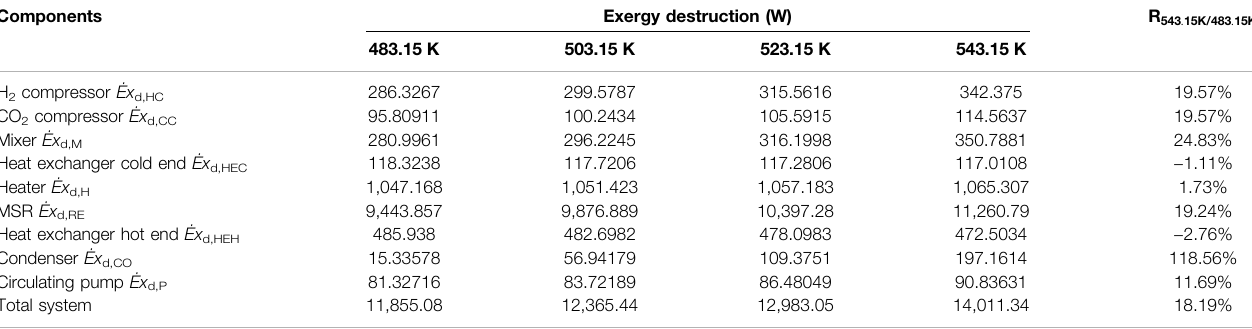
TABLE 4 | Exergy destructions in the CDHM system under different reaction temperatures. Components